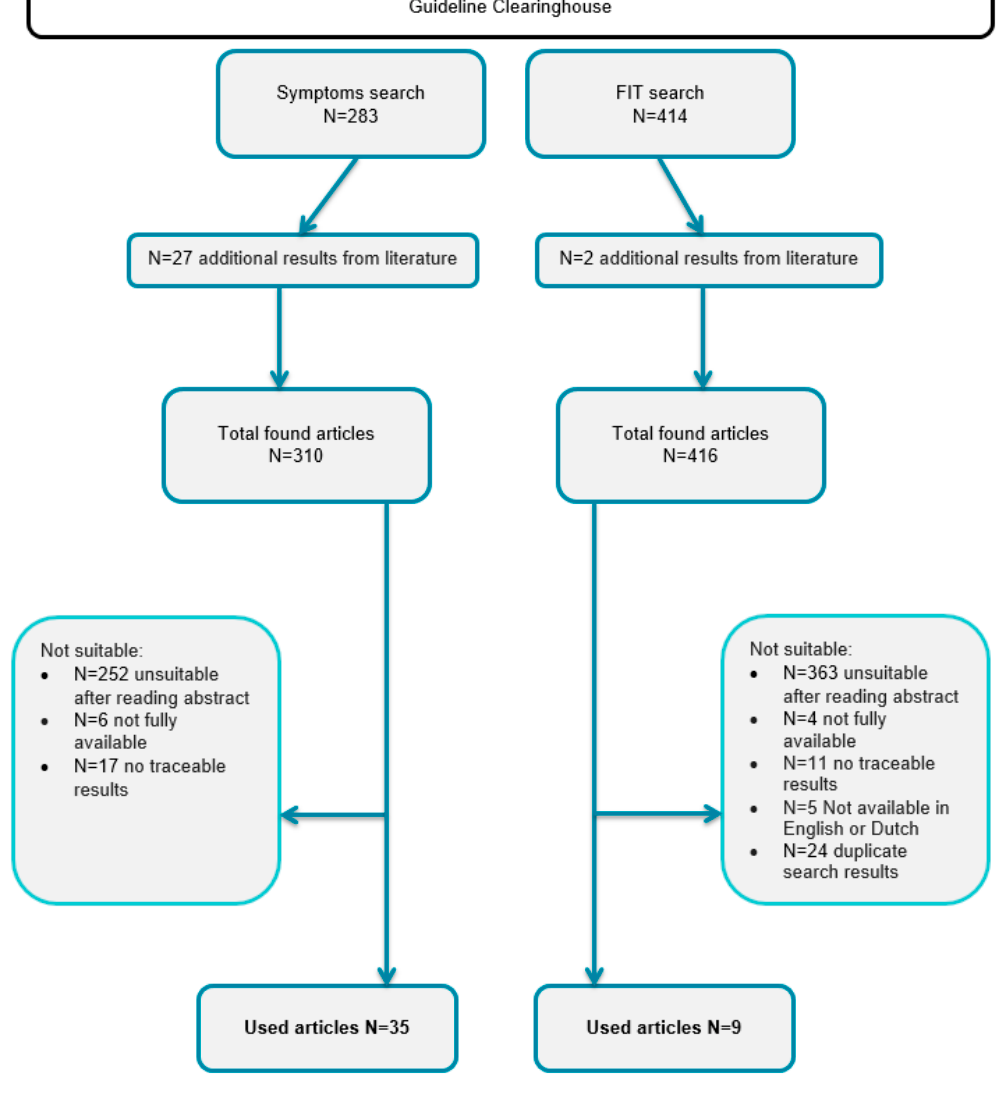
Figure 1. The publication searching procedure.